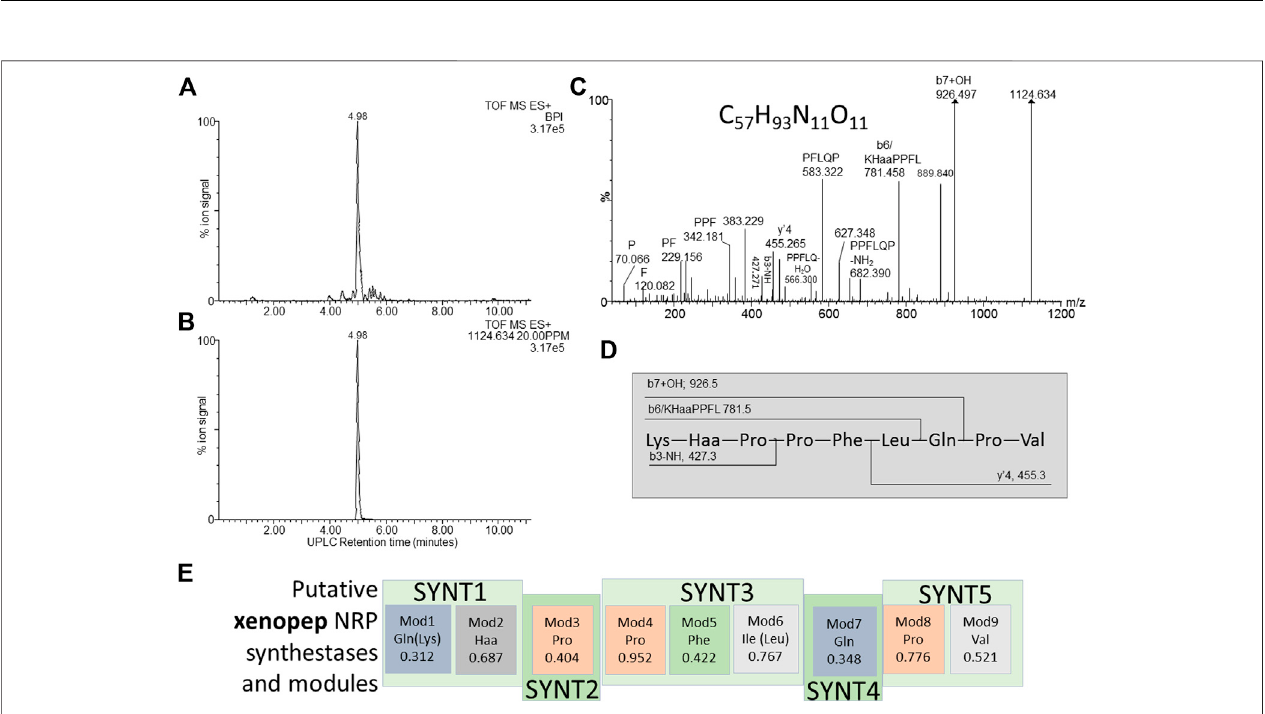
FIGURE 8 | Structural analyses of compound 15 – xenopep. (A) UPLC-MS analysis of the puri fi ed compound and (B) the extracted m/z chromatogram of the xenopepionwith m/z (cid:1) 1,124.364; (C) highresolutionMS-MSspectrumof1,124.364annotatedwithputativeionidentities; (D) proposedworkingstructureforxenopep; (E) putativeNRPS operonforxenopepwiththepredictedaminoacidsforeach module(Mod) inthesynthetase (SYNT)and probabilityscore(the greaterthenumber the lower the probability). The amino acids found with amino acid analysis and MS-MS are given in brackets.